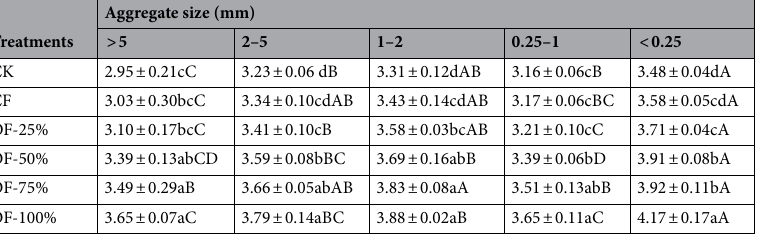
Table 4. Total organic carbon concentration (g per kg) within soil aggregates in different fertilization treatments in a gravel-mulched field. Lower-case letters in the same column indicate significant differences in fertilization. Upper-case letters in the same row indicate significant differences in aggregate size ( p < 0.05). CK, no N fertilizer; CF, N fertilizer without organic fertilizer; OF-25%, OF-50%, OF-75%, and OF-100%, 25%, 50%, 75%, and 100% organic fertilizer.